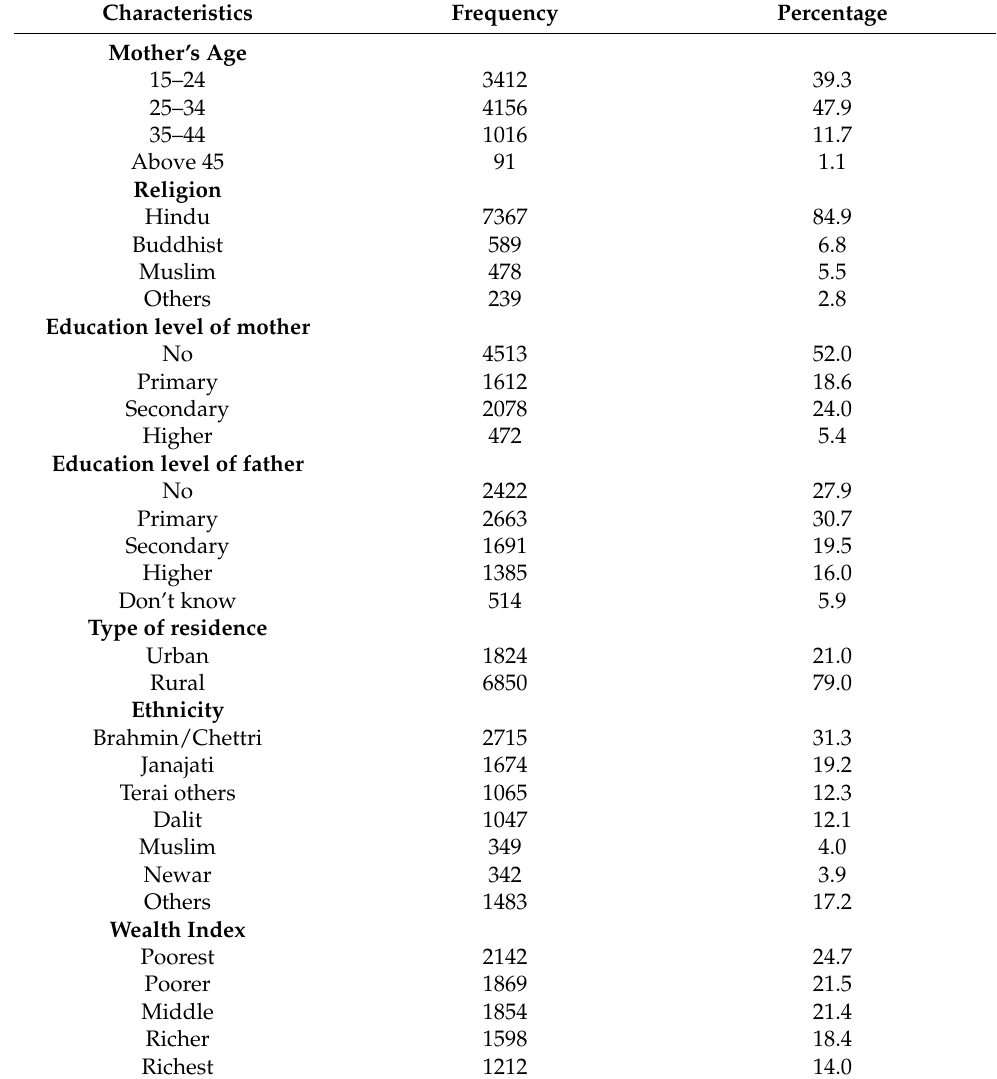
Table 1. Sociodemographic characteristics of respondents/households, n = 8885. Characteristics